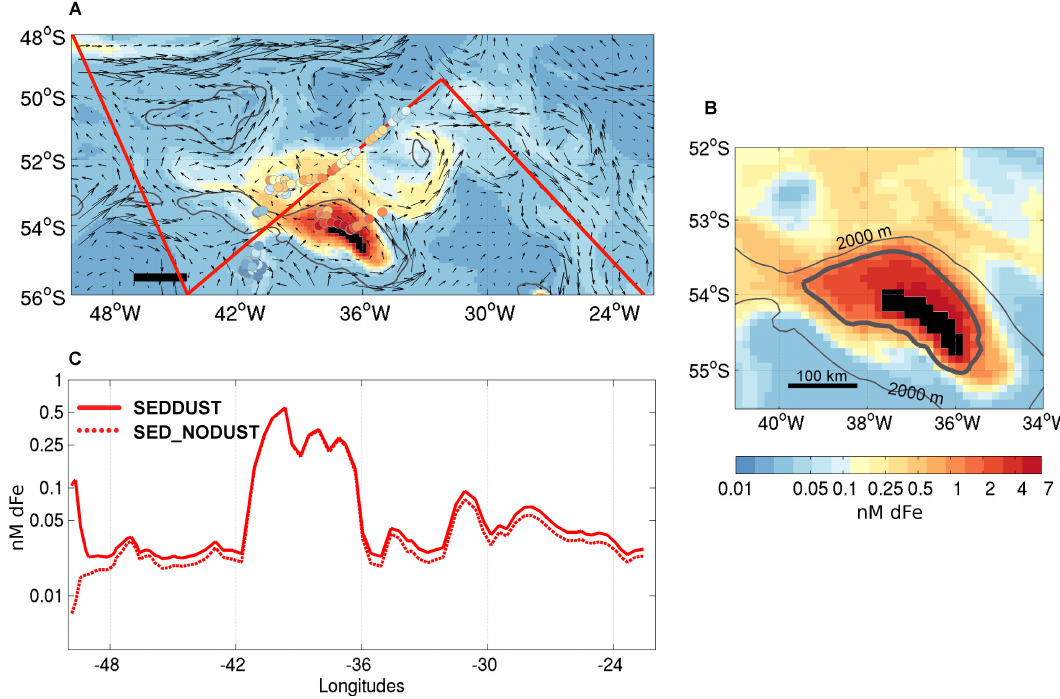
Fig. 9. Simulated surface (0–30m) dFe concentrations for January–February of the last modelling year. In (A) dFe concentrations (colour- scale as in B ) are obtained from the SEDDUST scenario; coloured dots indicate in situ surface dFe concentrations measured by Nielsdóttir et al. (2012), shown also in Fig. 7a. The red line marks a virtual transect along which are extracted modelled dFe concentrations depicted in C ; black arrows represent the contemporaneous surface circulation as depicted in Fig. 4b; the horizontal bar indicates 1ms − 1 and corresponds to approximately 160km. (B) dFe concentrations from the SEDDUST scenario (detail from panel A ); the thick contour line indicates dFe concentrations equal to 1.35nM, here marked to estimate dFe scale lengths; see text for more details. (C) Modelled dFe concentrations for points along the red line drawn in A . Solid line depicts values obtained from the SEDDUST scenario (i.e. including sedimentary and atmospheric deposition of dFe), dashed line depicts dFe values obtained from the SED_NODUST scenario where there is no atmospheric deposition of